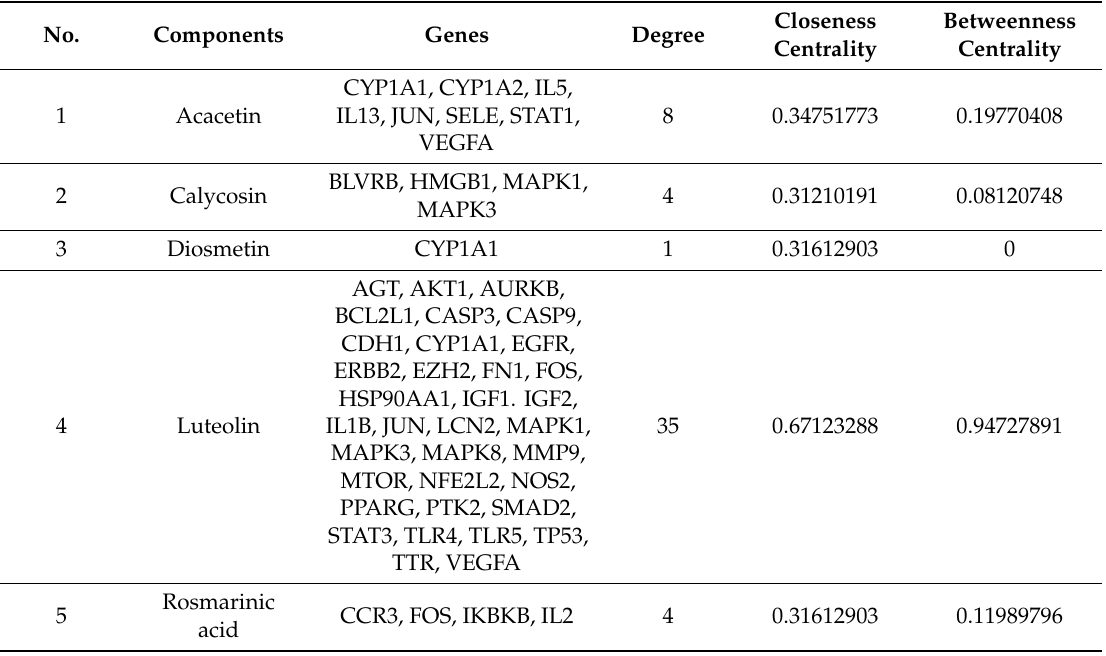
Table 1. Network of five small molecules and 45 gastritis-related